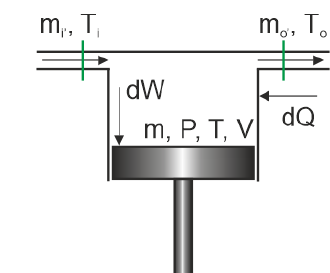
Fig. 9 the scheme of the cylinder workspace was shown.